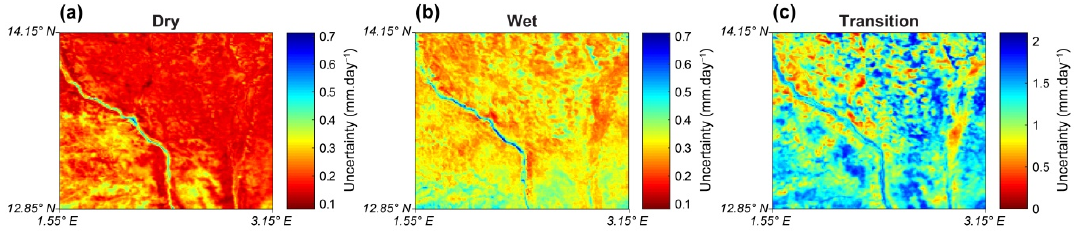
Figure 11. Spatial distribution of temporal mean uncertainty on E3S daily blended ET d estimates over the study period for ( a ) the dry season, ( b ) the wet season, and ( c ) the transition period. E3S uncertainty is defined as the conditional ensemble range. Please note the different color scale in ( c ).